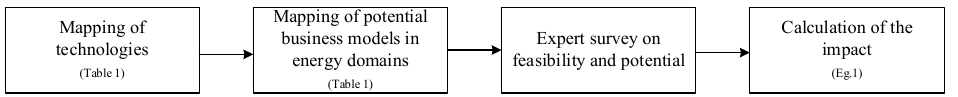
Fig. 1. Algorithm of used